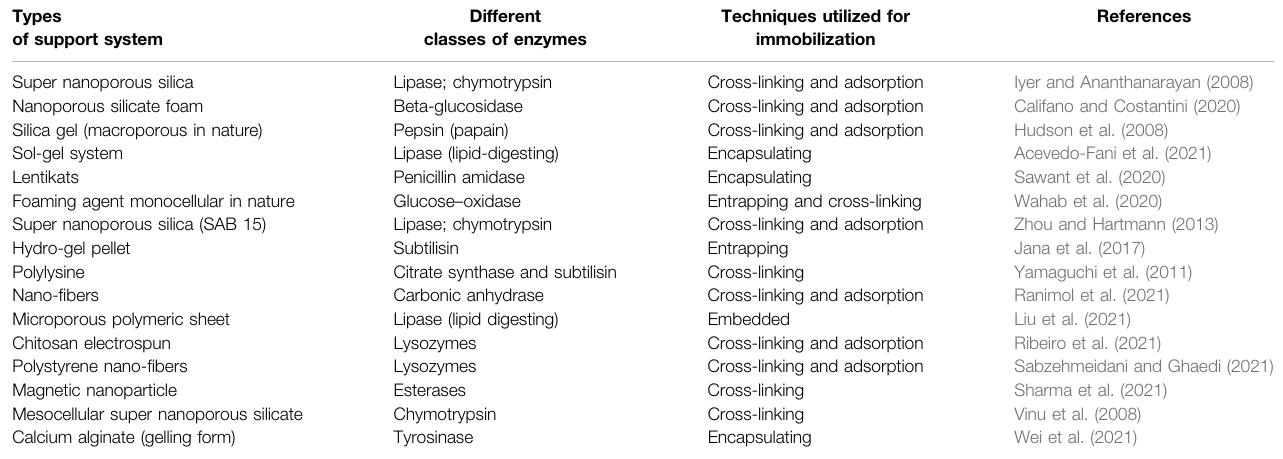
TABLE 2 | Various types of support systems used in